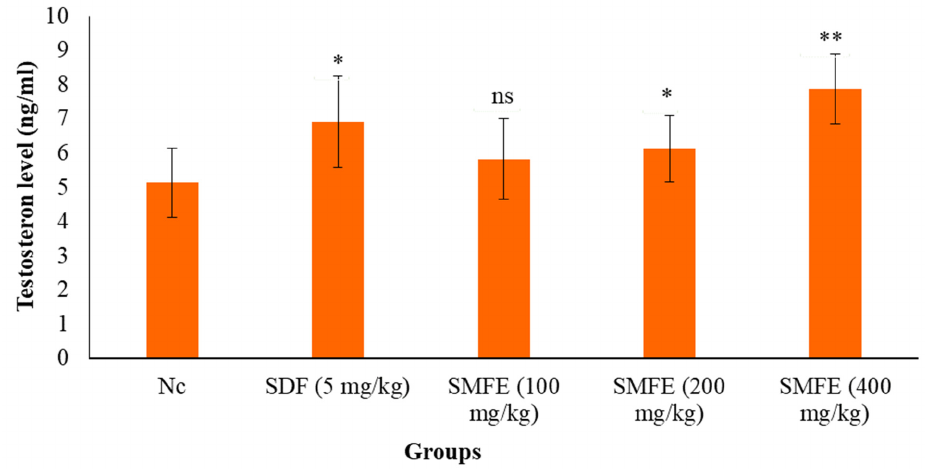
Figure 11. Effect of S. mangifera fruit extract on testosterone level ( n = 6). The values are means ± SEM; * p < 0.05, ** p < 0.1; ns p > 0.05 (followed by Student Dunnett test).